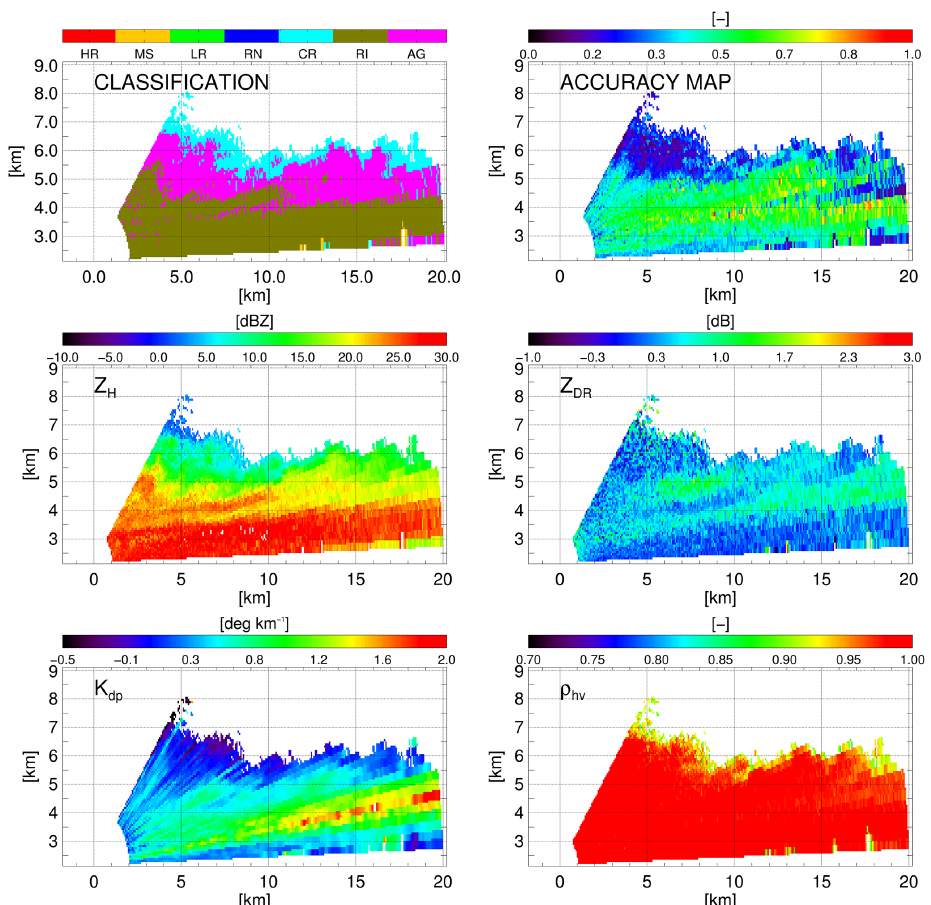
Figure 10. As in Fig. 8 but for the snowfall event of the 26 March 2010, at 15:31UTC in Davos (CH). The altitude of the radar is